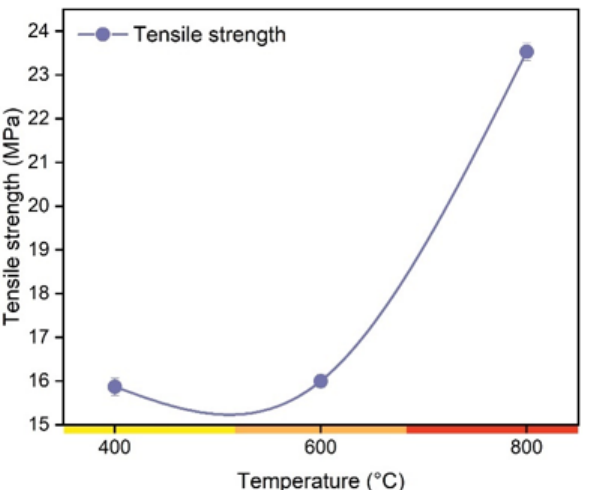
Figure 8. Tensile strength of biocomposites produced from charcoal fines obtained at different pyrolysis temperatures.